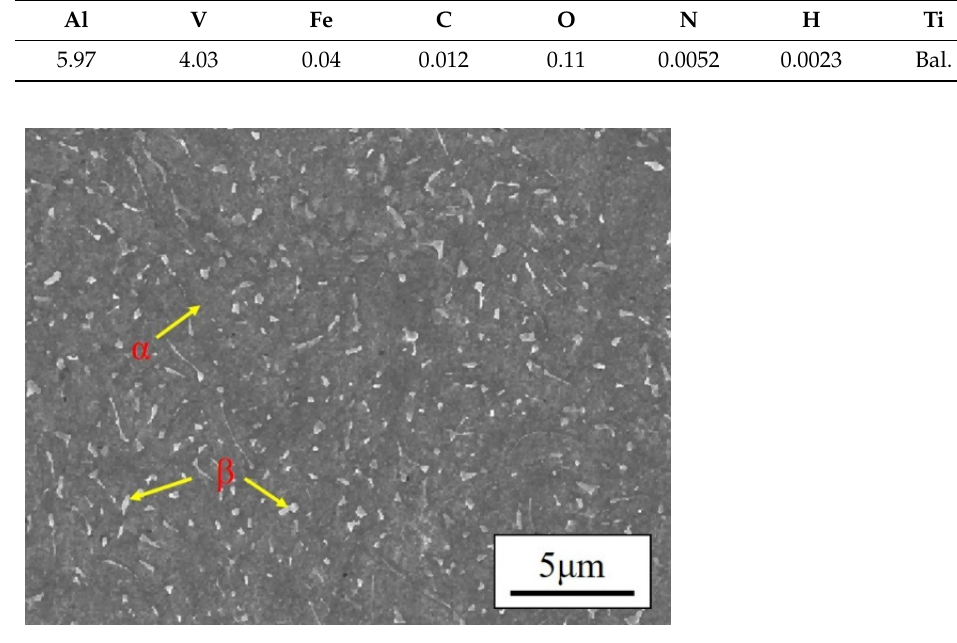
Figure 1. Initial microstructure of TC4 alloy. Table 1. Chemical composition of the TC4 alloy (wt.%) in as received condition. Table 2. Tensile properties of TC4 alloy initial